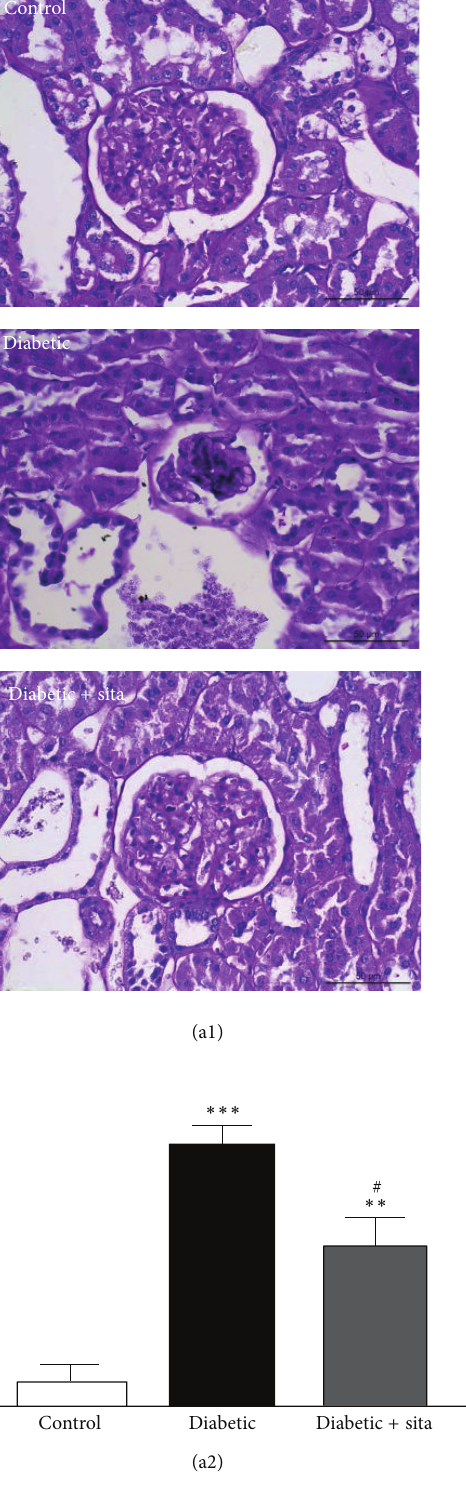
Figure 2: Effects of sitagliptin treatment on renal lesions in the kidney induced by diabetes, such as glomerular atrophy (a) and interstitial fibrosis/tubular atrophy (IFTA) (b) in ZDF (+/+) and ZDF ( fa/fa ) nontreated or treated with sitagliptin. (a1) and (b1) are representative images of renal histology (PAS staining) Data are expressed as mean ± SEM ( 𝑛 ≥ 6 per group); ∗∗ 𝑃 < 0.01 and ∗∗∗ 𝑃 < 0.001 significantly different from control; # 𝑃 < 0.05 significantly different from